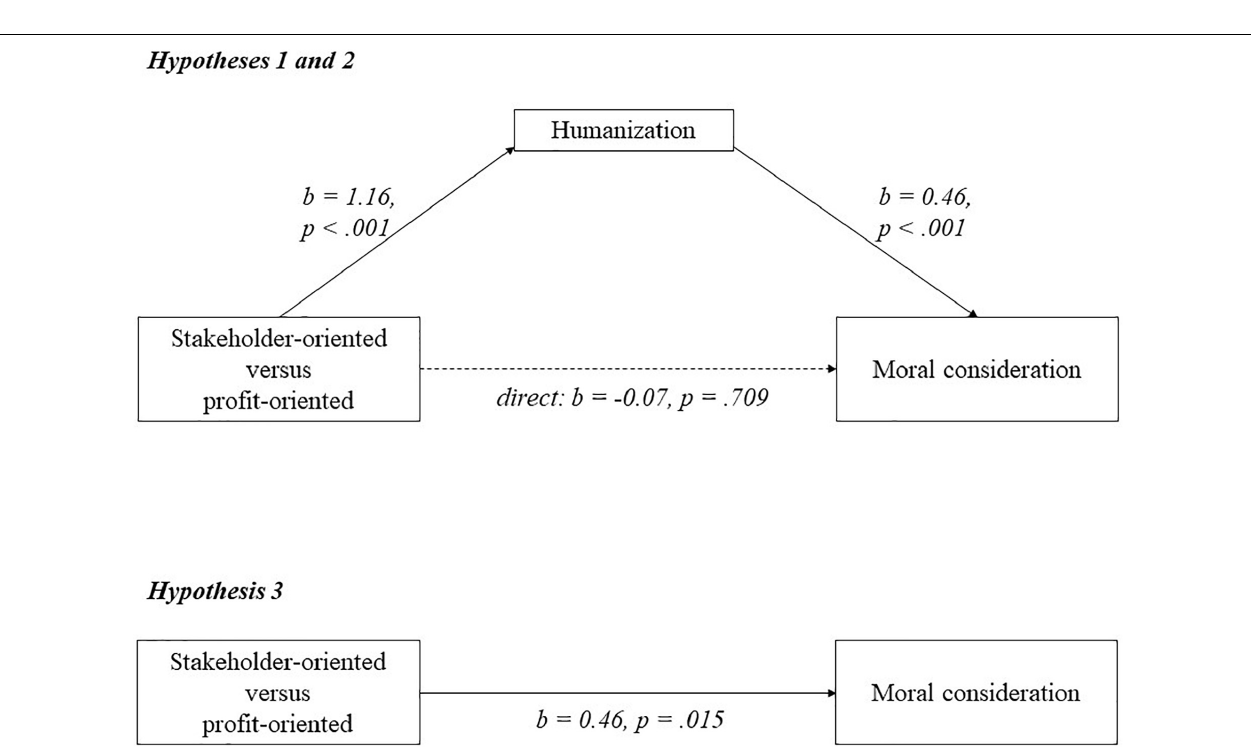
FIGURE 4 | A model of mediation indicating that the relationship between business orientation and moral consideration goes via humanization in experiment 5.